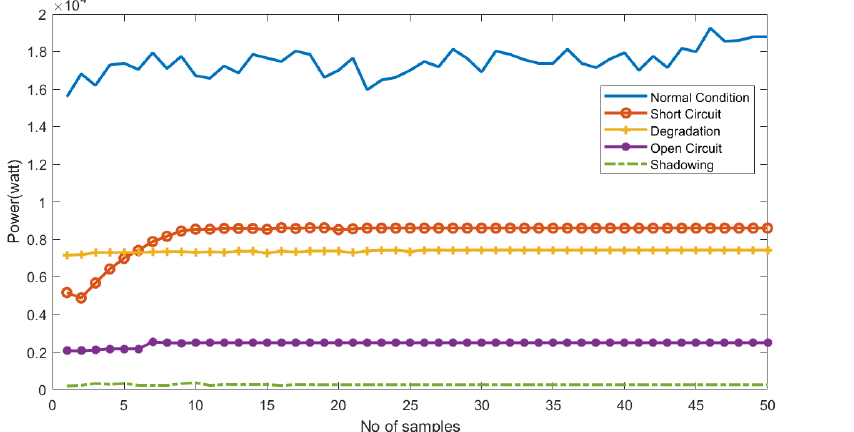
Figure 5. The PV power production under normal and faulty